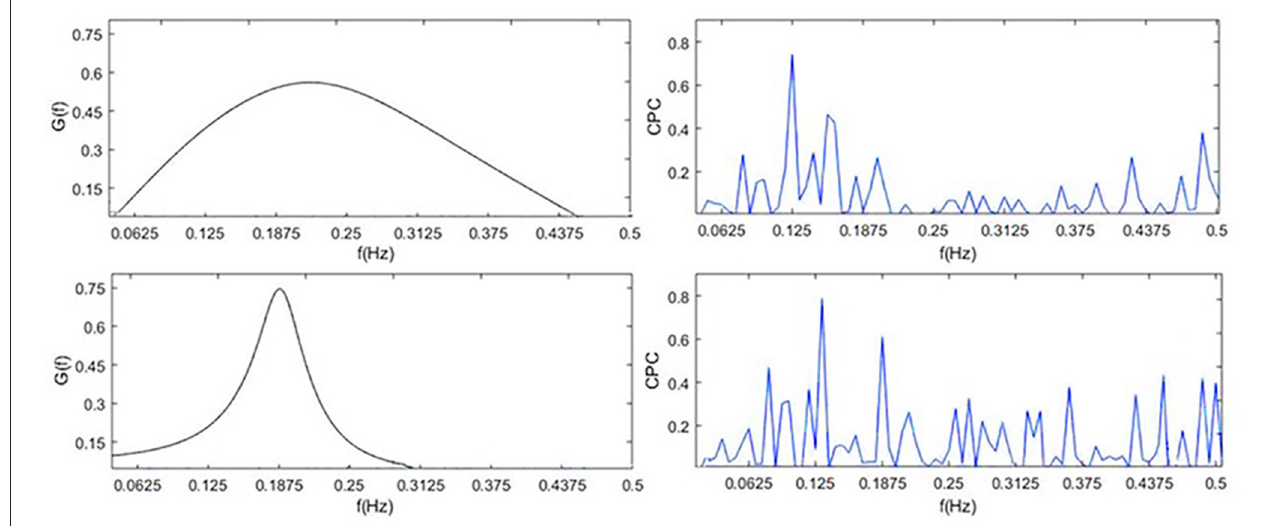
FIGURE 7 | G(f) (CRF) and CPC in light sleep (top) and deep sleep (bottom).